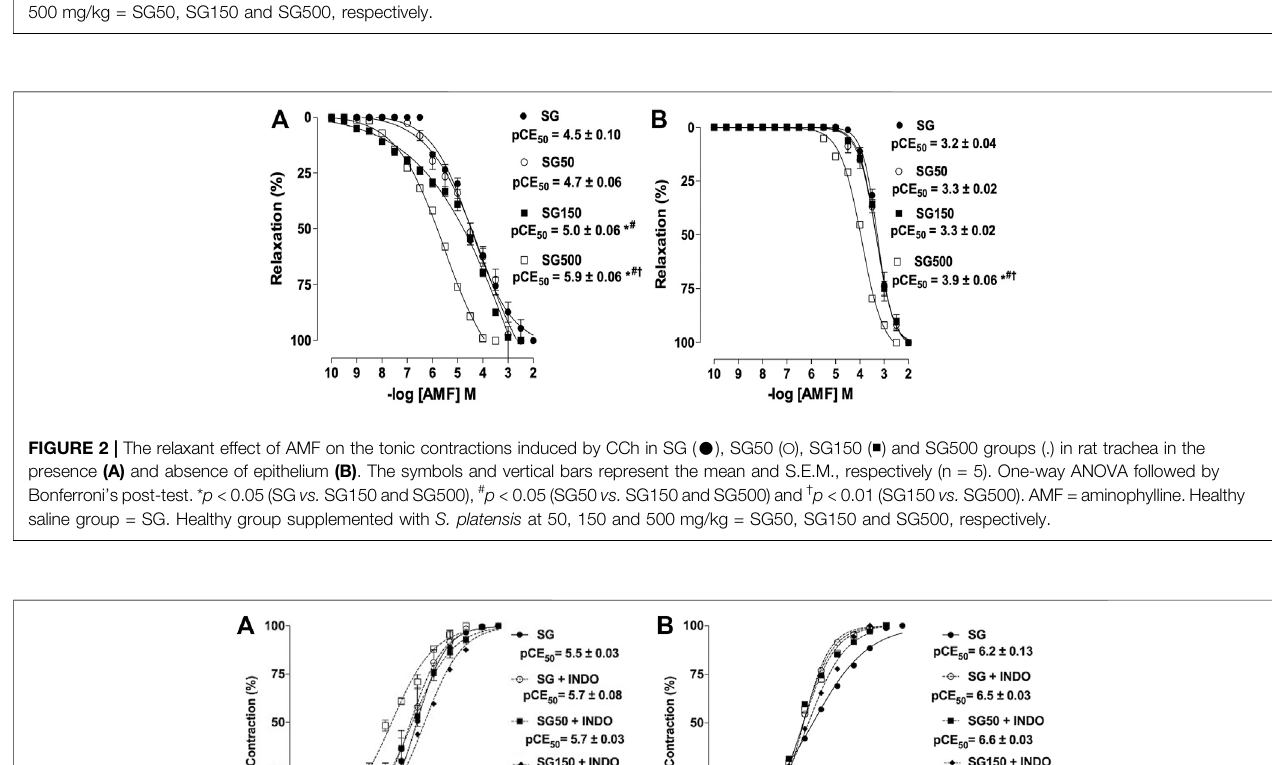
Frontiers in Pharmacology |